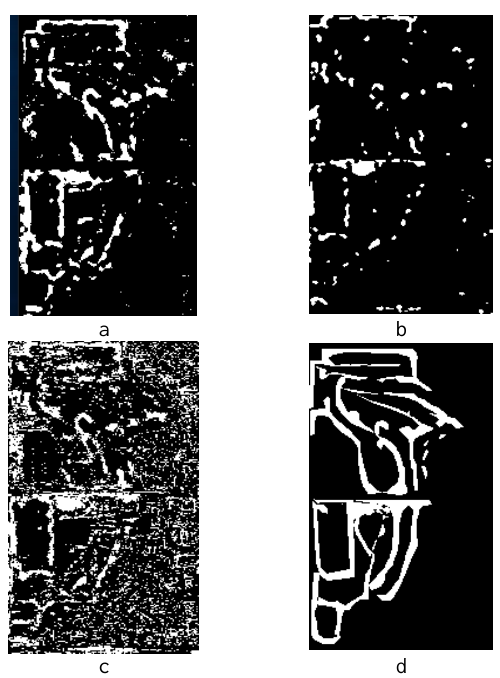
Fig. 9. Change detection results in Region 2, (a) proposed method, (b) test statistic based on Wishart distribution, (c) k- means clustering, (d) ground truth